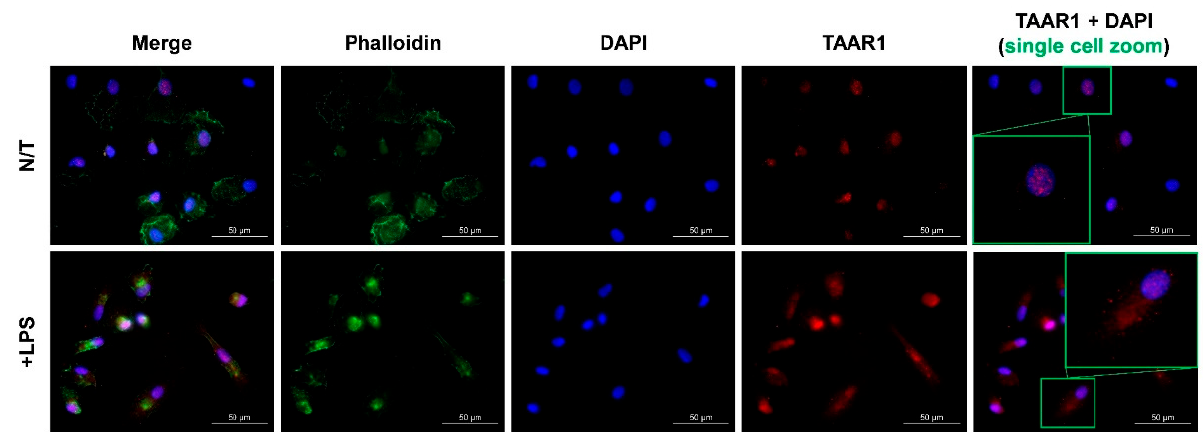
Figure 2. TAAR1 localization within basal and LPS-stimulated CD14+ monocyte-derived macrophages from healthy vol-